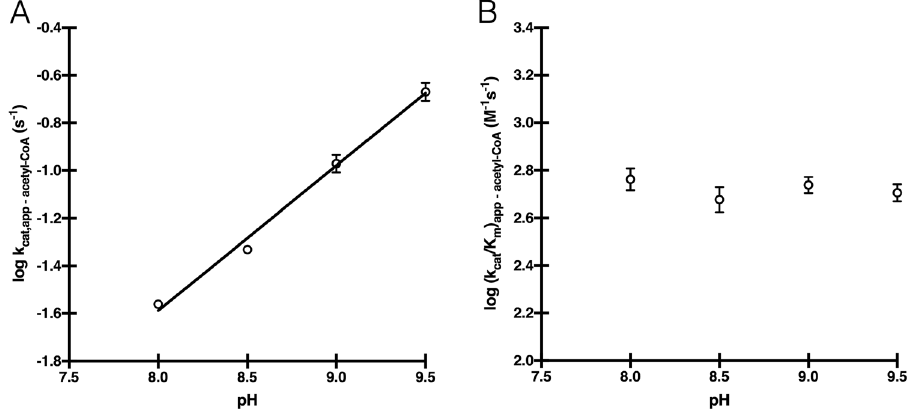
Figure 6. E34A pH-rate profiles. ( A ) k cat,app for acetyl-CoA. ( B ) (k cat /K m ) app for